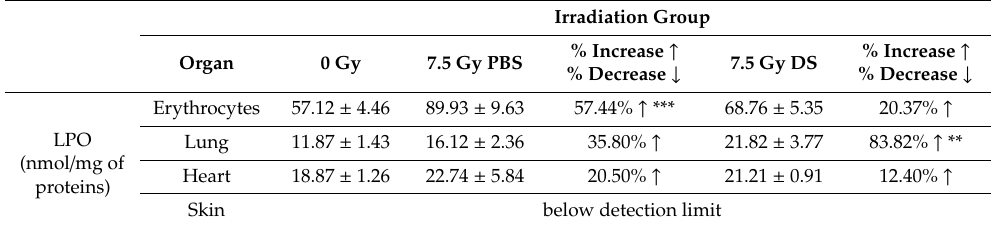
Table 5. LPO in erythrocytes, lung, heart and skin of mice irradiated by PBS or DS proton beams in the plateau phase of the Bragg peak.